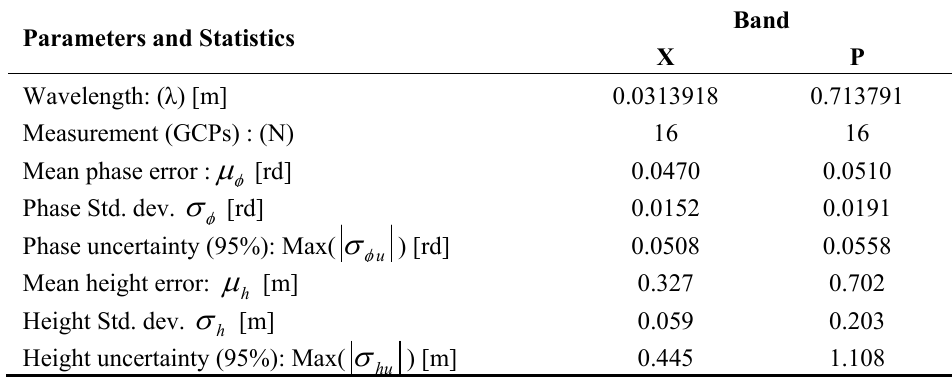
Table 5. Statistics regarding the phase-offset estimation error of the proposed method for X- and